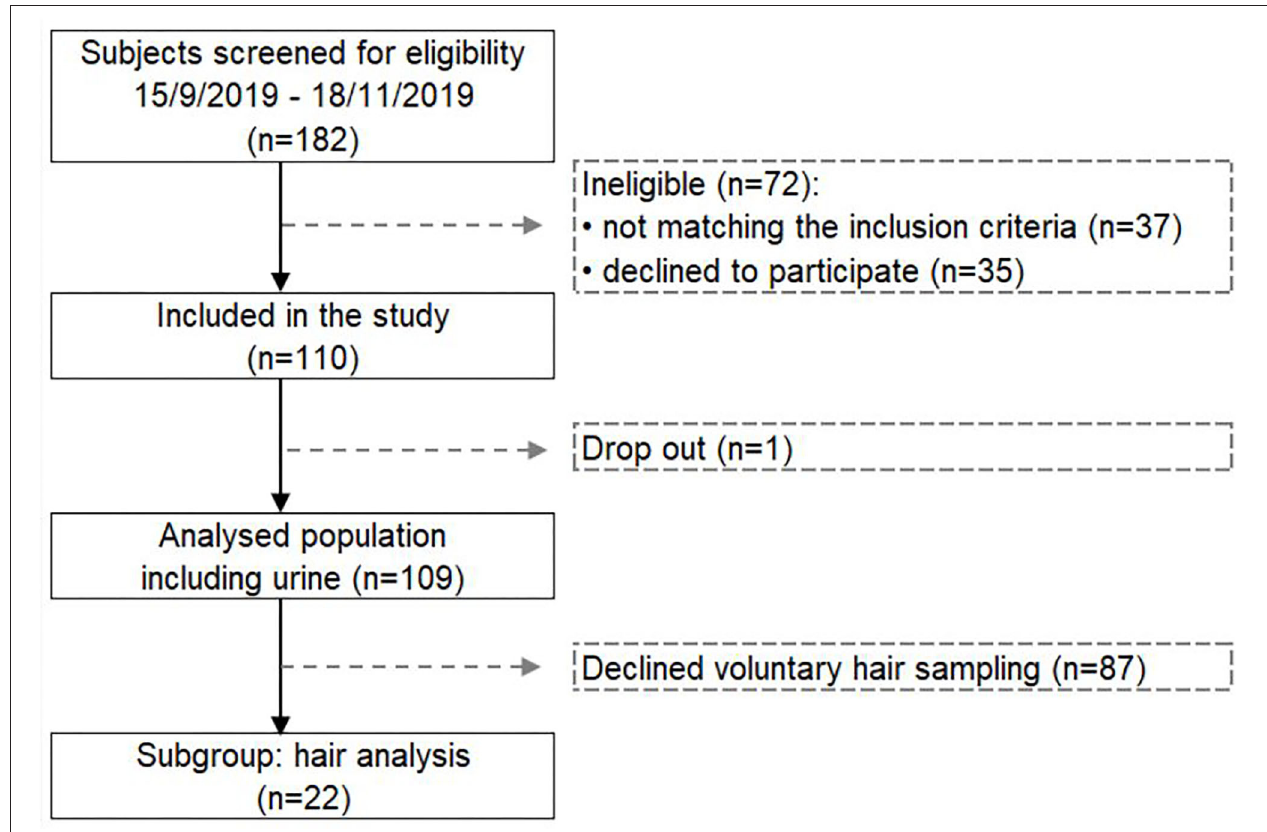
FIGURE 1 | Flow chart presenting the selected study population for measuring the changes in heavy metals and glyphosate excretion during long-term fasting.